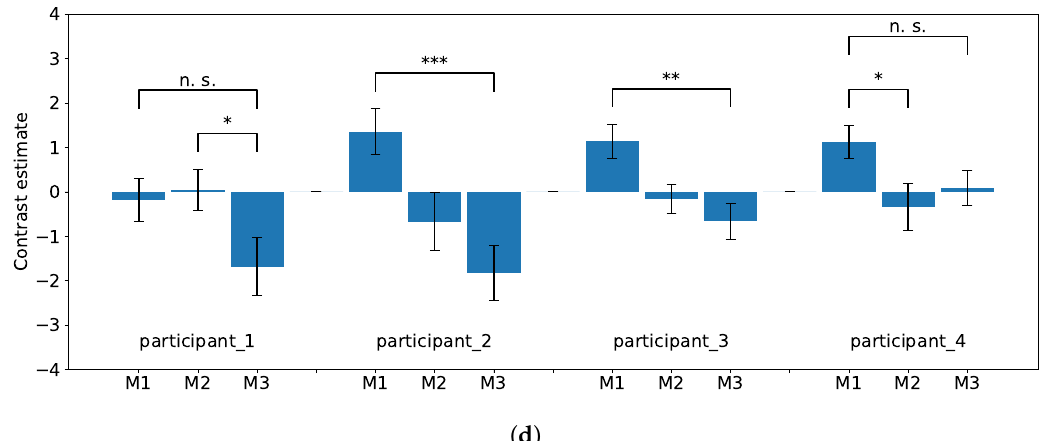
Figure 8. Trends in brain activities in different locations of the brain. For all plots, the Mean ± SE is displayed. Asterisks indicate p -values (n.s. p > 0.05, * p ≤ 0.05, ** p ≤ 0.01, *** p ≤ 0.001 for the two-tailed Welch’s t -test). ( a ) Trends in brain activity in the premotor cortex.; ( b ) Trends in brain activity in the parietal lobe.; ( c ) Trends in brain activity in the dorsolateral prefrontal cortex.; ( d ) Trends in brain activity in the inferior frontal